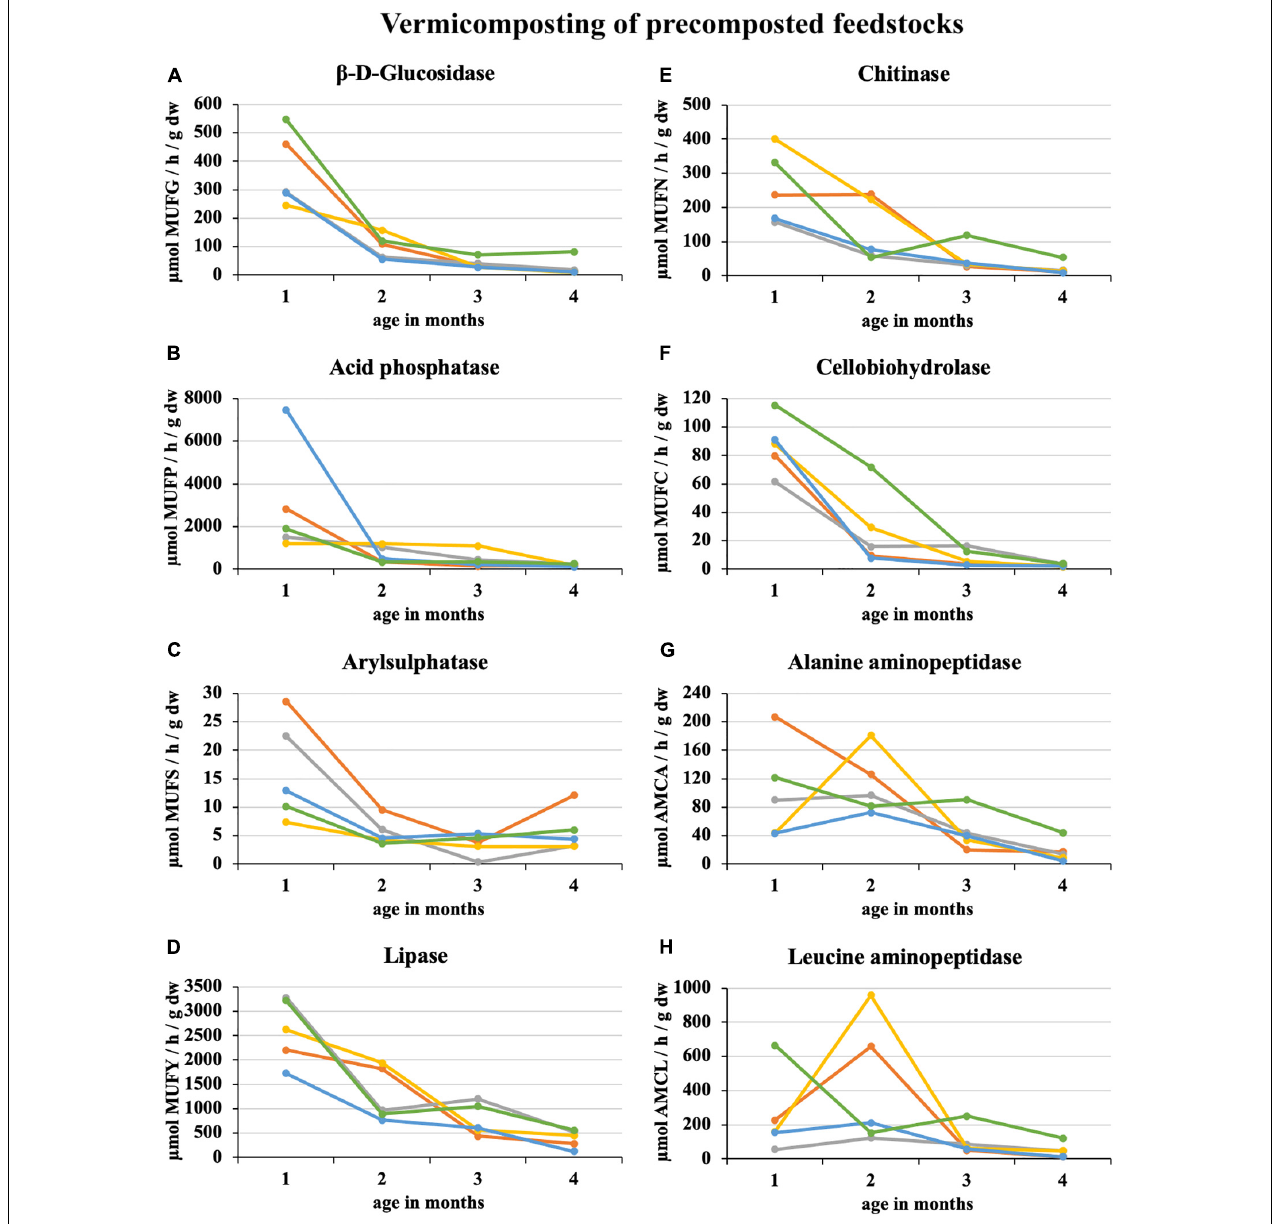
FIGURE 3 | Course of enzymatic activity during vermicomposting of precomposted feedstock. , sludge 100% with earthworms; , sludge 75% + PWS 25% with earthworms; , sludge 50% + PWS 50% with earthworms; , sludge 25% + PWS 75% with earthworms; , PWS 100% with earthworms; PWS, pelletized wheat straw; dw, dry weight; MUFG, 4-methylumbellyferyl- β -D-glucopyranoside; MUFP, 4-methylumbellyferyl-phosphate; MUFS, 4-methylumbellyferyl sulfate potassium salt; MUFY, 4-methylumbellyferyl-caprylate; MUFN, 4-methylumbellyferyl-N-acetylglucosaminide; MUFC, 4-methylumbellyferyl-N-cellobiopyranoside; AMCA, L-alanine-7-amido-4-methylcoumarin; AMCL,